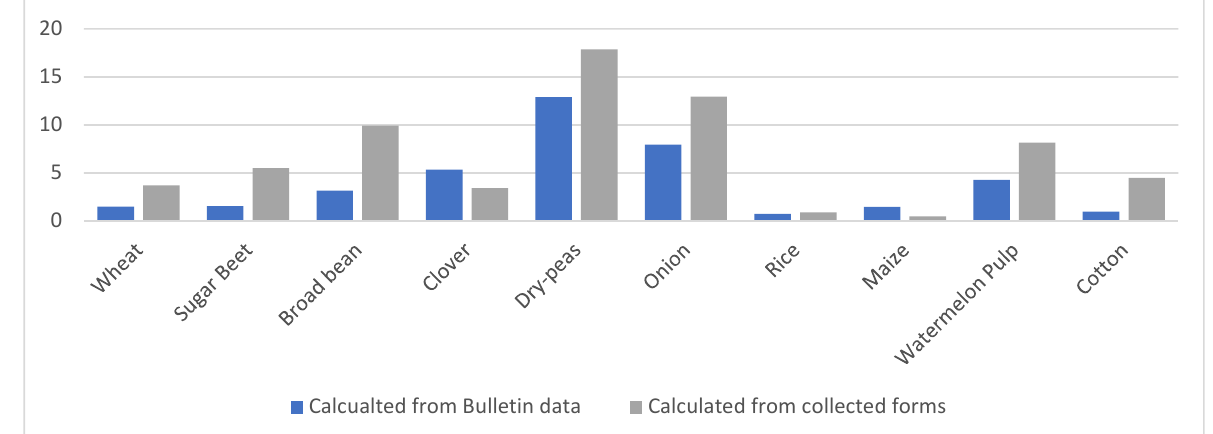
Figure 4. Water Profitability for Kafr El-Sheikh Governorate from Bulletin data compared to collected forms. Source: In blue, Ministry of Agriculture and Land Reclamation–Economic Affairs Sector’s Agricultural Statistics Bulletin for 2019 and Land and Water Research Institute–Water Standards Department’s unpublished data. In gray are the in-person forms collected in 2020.